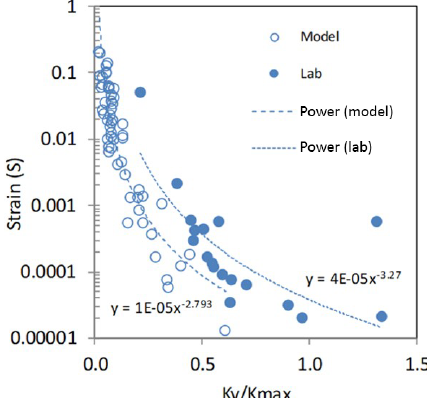
Figure 11. Strain versus K Y /K max ratios from numerical simu- lations (hollow circles) and laboratory experiments (solid circles). Strain at given ratios of the yield acceleration ( K Y ) to the maxi- mum of the average acceleration of the mass ( K max ), in response to a given dynamic load adopting the piezometric base levels derived from field monitoring of piezometric head levels in the